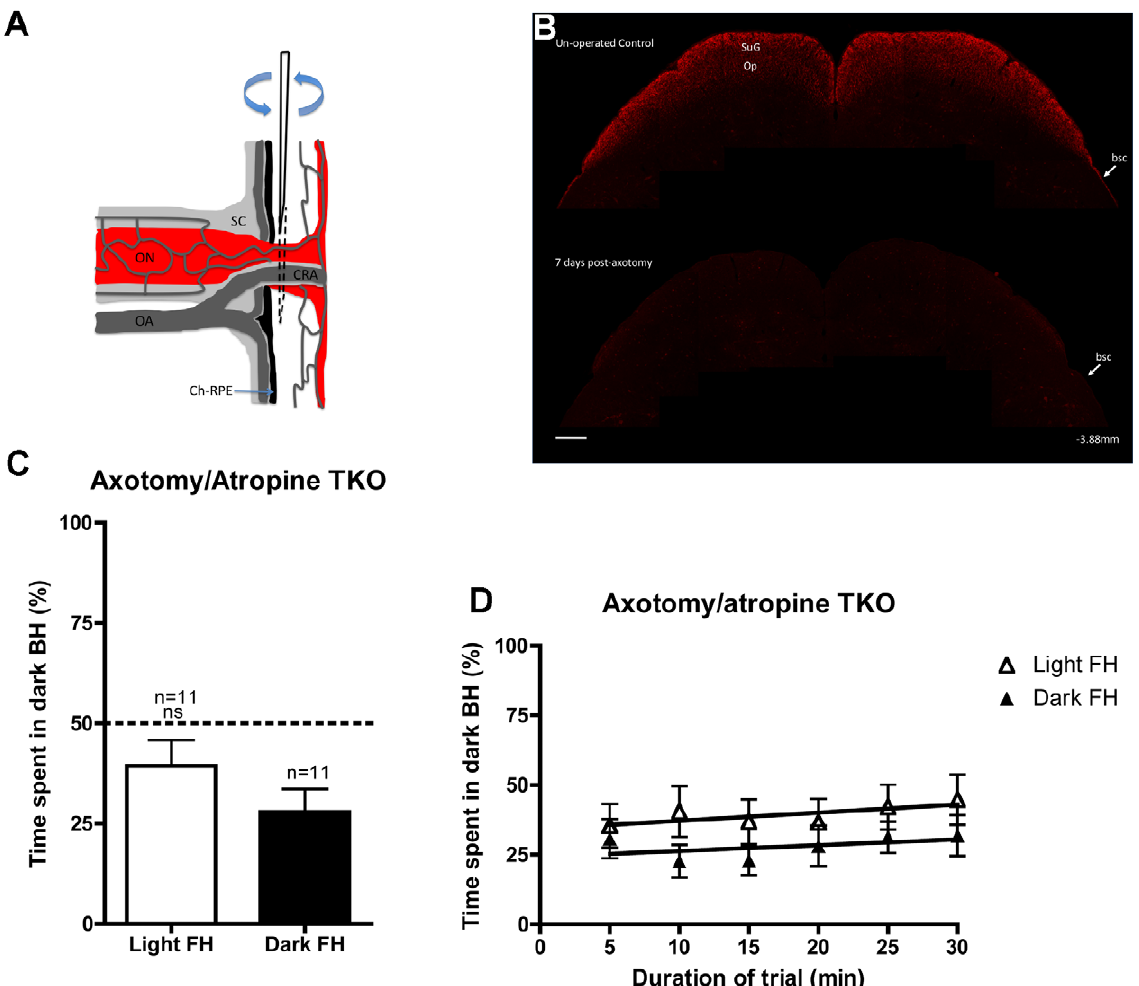
Figure 5. Axotomy abolishes the atropine-induced light aversion response in TKO mice. ( A ) Diagramatic illustration of the axotomy technique (image modified from [75] ), a swift back and forth movement of the needle severs both the optic nerve and central retinal artery. ( B ) Immunoreactivity for calretinin positive retinal afferents (red) is abolished in the superficial gray (SuG) and the optic nerve (Op) layers of the superior colliculus of a bilaterally axotomised TKO (bottom) compared to an unoperated contol (top). Collicular sections are 2 3.88 mm from bregma [76], scale bar is 200 m m. ( C ) Behavioural aversion to light in atropine-treated TKO mice is abolished in bilaterally axotomised animals. ( D ) Time spent in the dark back half (BH) of the arena over the course of the 30-minute trial. White triangles, from trials when the front-half (FH) is in light, black triangles when the FH is in darkness. Abbreviations: bsc, brachium of the superior colliculus; Ch-RPE, choroid retinal pigment epithelium; CRA, central retinal artery; ns, not significant; OA, ophthalmic artery, ON, optic nerve; Sc, sclera.